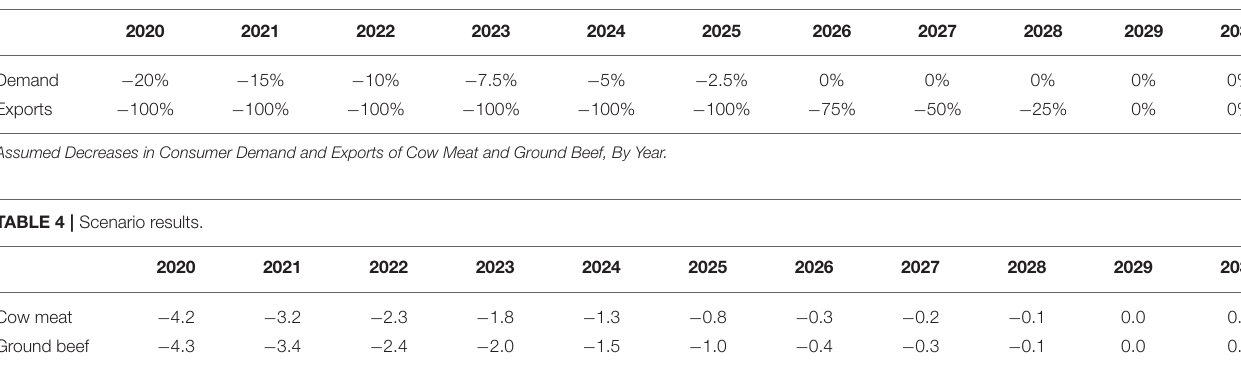
TABLE 3 | Scenario assumptions.